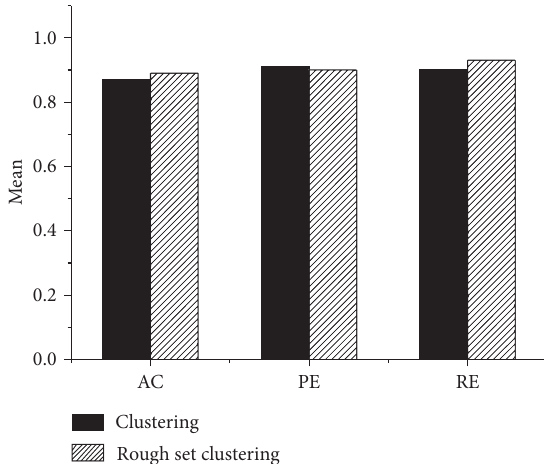
Figure 9: Comparison on performance of clustering algorithm on the Soybean data